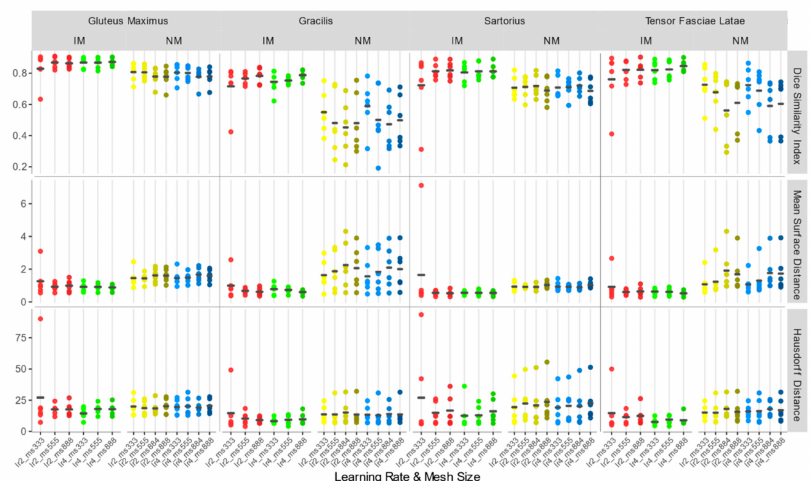
Figure 9. DSI, MSD (mm), and HD (mm) for each individual considered muscle (Gluteus Maximus, Gracilis, Sartorius, Tensor Fasciae Latae) for non-rigid registration schemes.